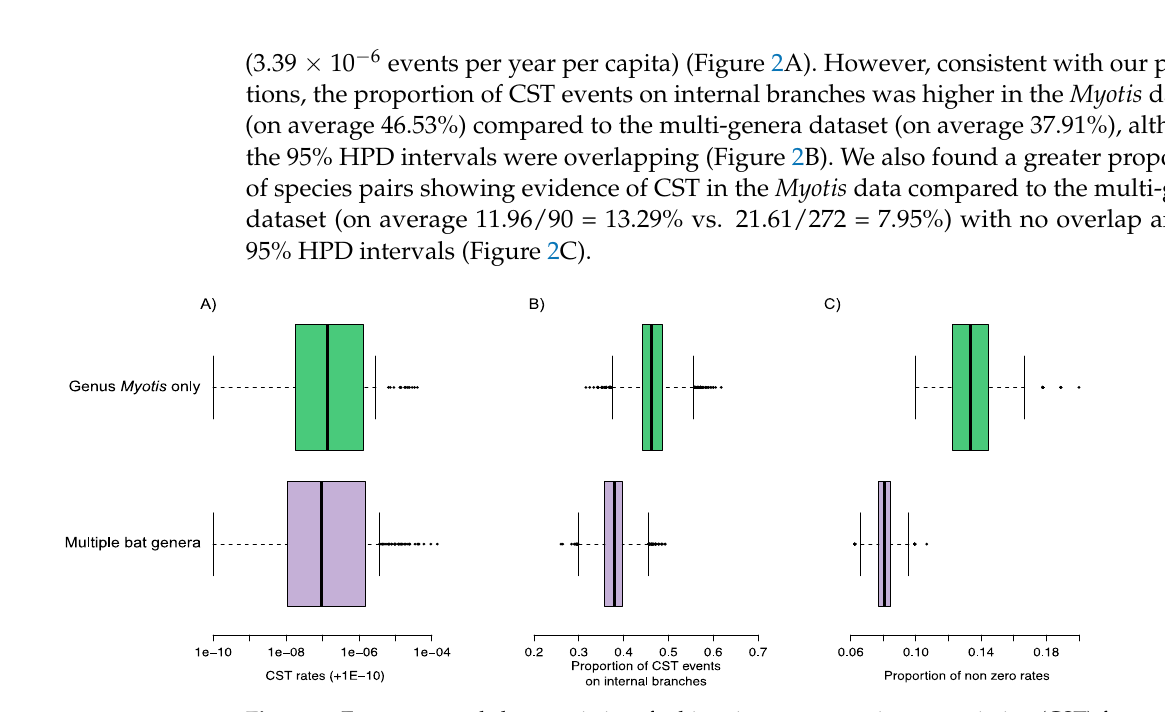
Figure 2. Frequency and characteristics of rabies virus cross-species transmission (CST) for ten North American bat species within the genus Myotis , compared to a dataset containing multiple genera of North American bats. Posterior distributions of ( A ) the mean rates (+1E − 10 ) of inferred CST events per year per capita for all pairs of species on a log scaled x axis; ( B ) the proportion of CST events on internal branches (indicative of sustained transmission and host shifts); ( C ) the proportion of species pairs with non-zero rates.